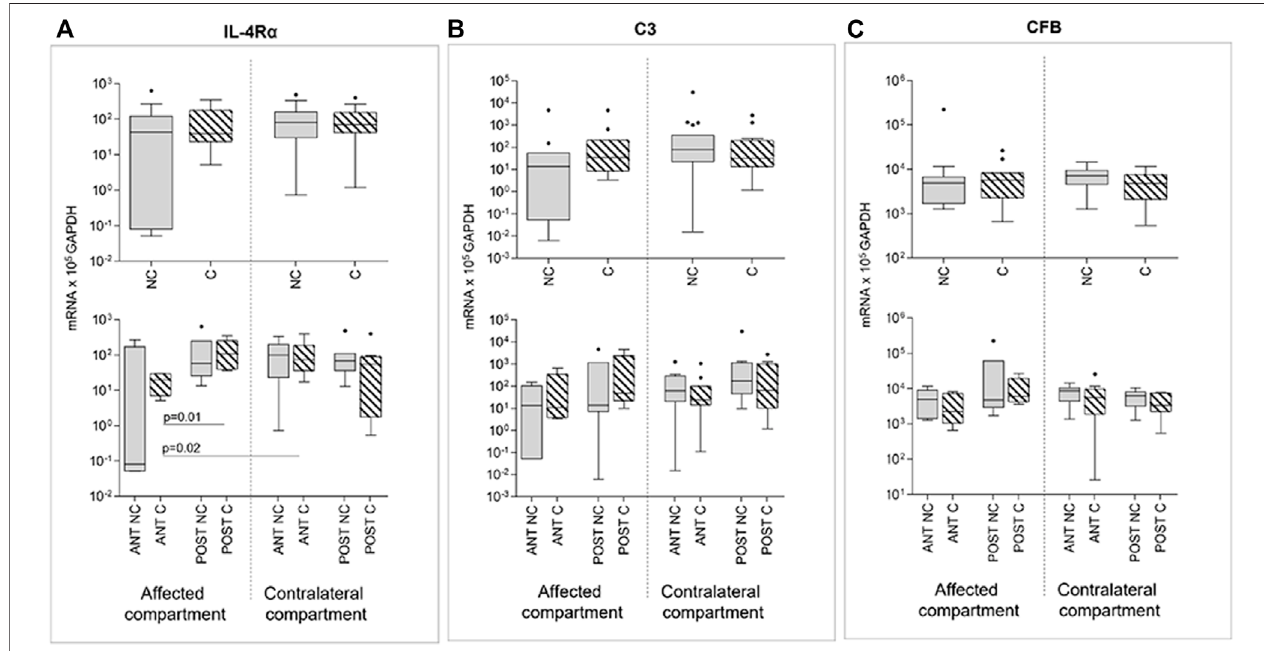
FIGURE6| Effectofcompression onIL-4R α (A) ,C3 (B) ,andCFB (C) geneexpressioninaffectedand contralateralcompartments(upperpanels). Inlowerpanels, samples are divided according to the original position of the cartilage area (anterior/posterior condyle) (Sidak test for multiple comparisons). Data are represented as medians (number of mRNA molecules of the gene of interest/10 5 GAPDH copies). Boxes represent 25 th – 75 th percentiles; whiskers represent minimum and maximum values; dots represent outliers. NC, uncompressed; C, compressed; IL-1 β , stimulated with 2 mg/ml IL-1 β